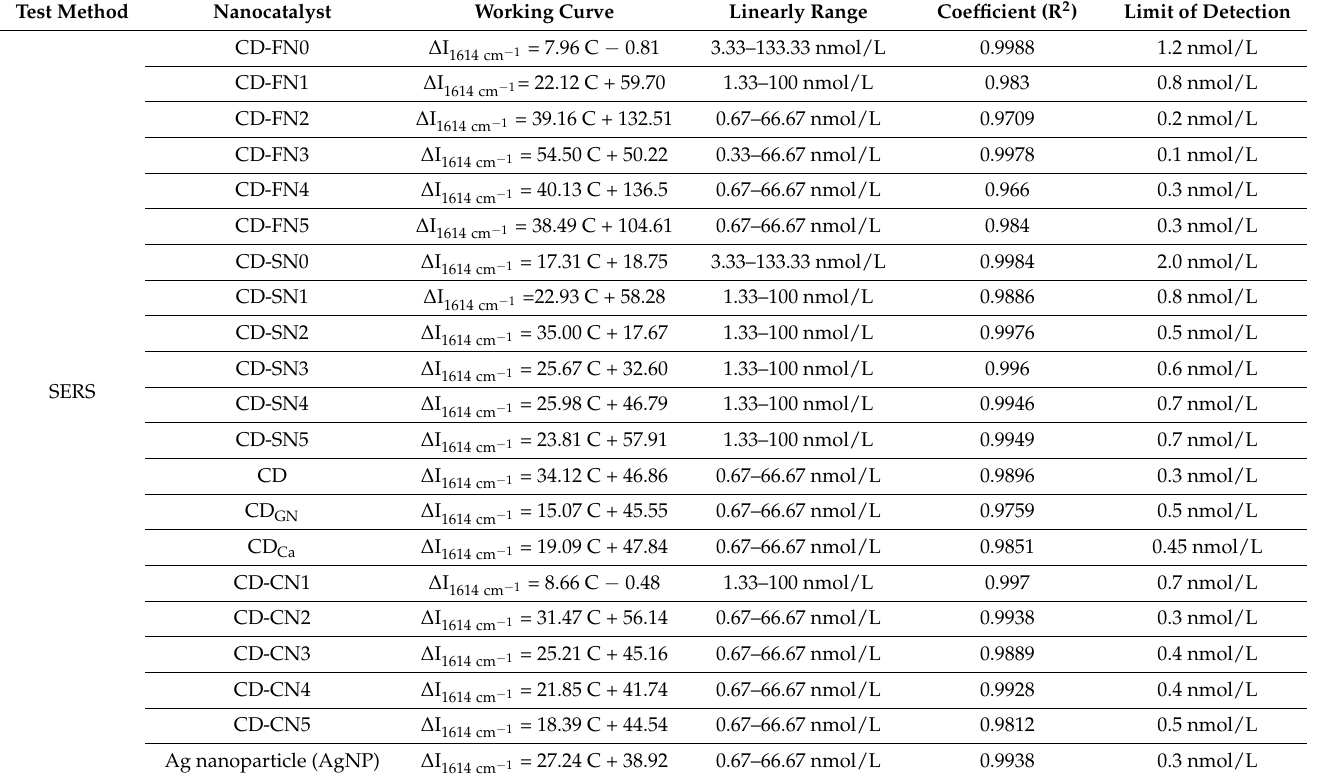
Table 1. Analytical characteristics of the Apt-adjusted catalysis and Ag nanoplasma SERS for the determination of